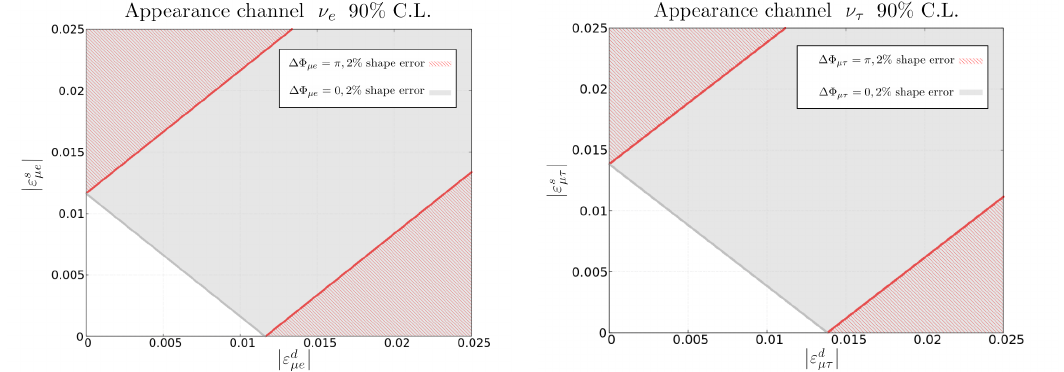
Figure 6 . Sensitivity to NSI in production and detection. Results are shown for effects on the P µe (left panel) and P µτ (right panel). In both panels the sensitivity is shown for the two limiting cases ∆Φ = π, 0 , which lead to a destructive and constructive interference between production and detection NSI respectively (see eq.